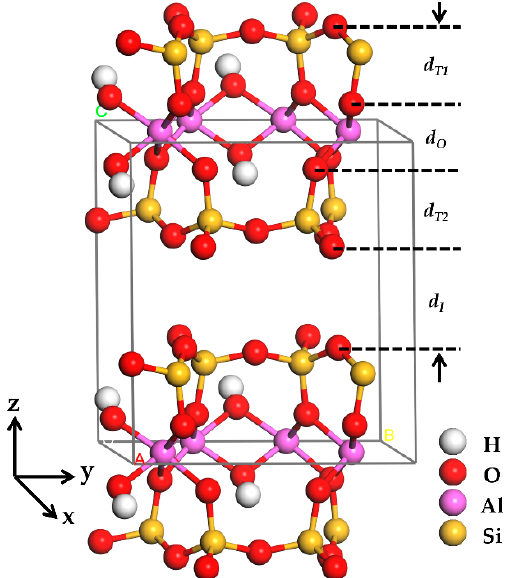
Figure 1. Unit cell of pyrophyllite [Al 4 Si 8 O 20 (OH) 4 ] containing 40 atoms. d T 1 and d T 2 —layer thickness of silicon oxide tetrahedral sheet; d O —layer thickness of aluminum oxide octahedral sheet; d I —interlayer thickness of two-dimensional layer. Table 1. Compared with experimental values, the calculated lattice parameters and volume of pyrophyllite [Al 4 Si 8 O 20 (OH) 4 ] using basis sets in this work. Exp.[39] This Work